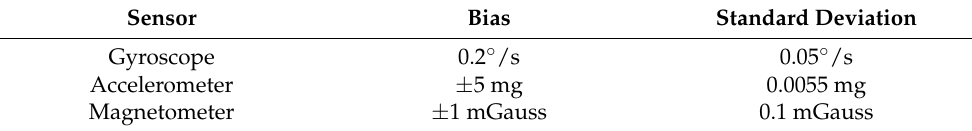
Table 1. The parameters of the MARG sensor of the self-designed measuring device.